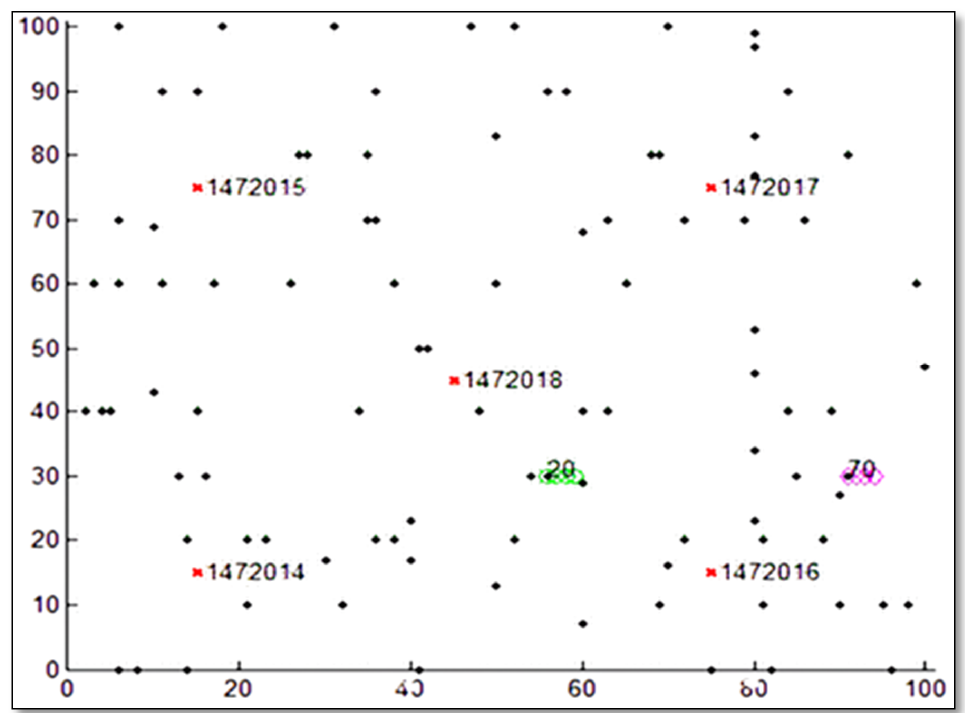
Figure 1. V2X simulation using MATLAB.